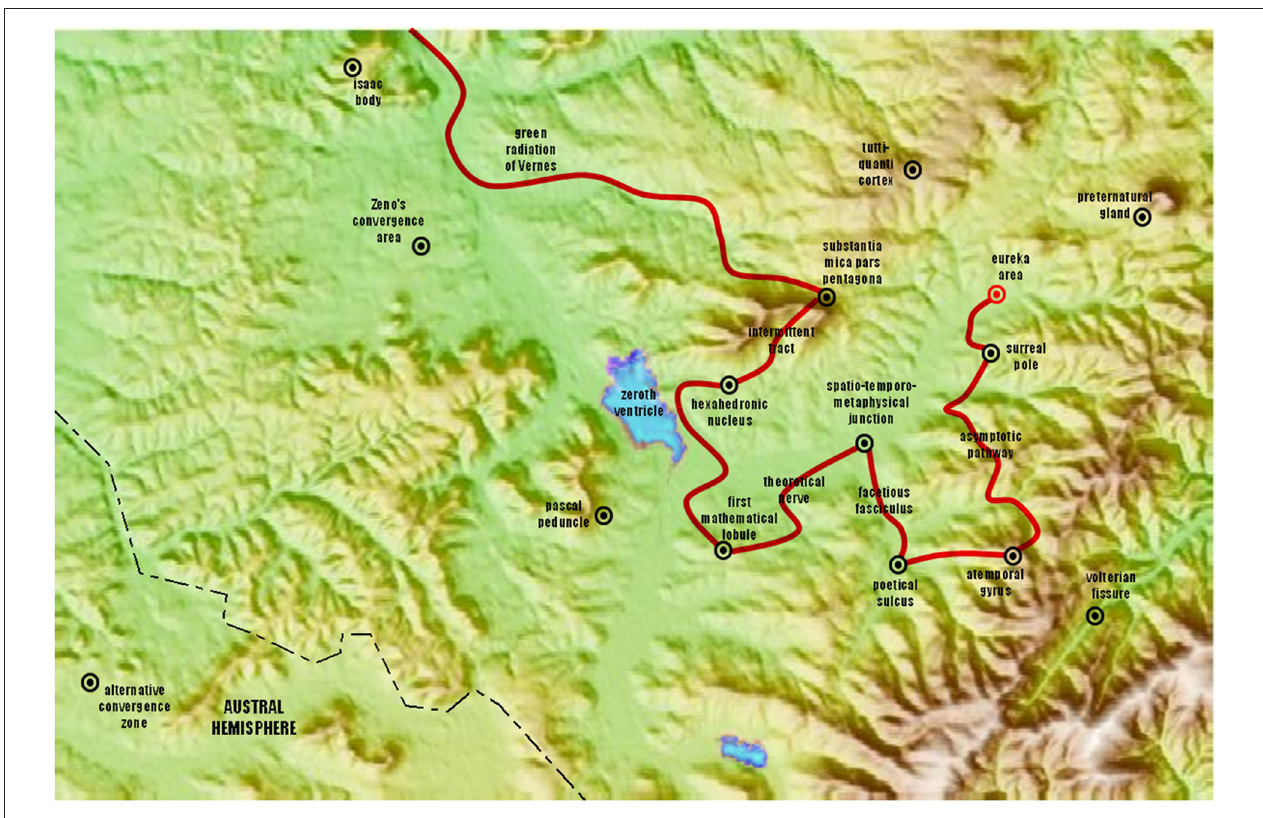
temporal neighborhoods, and it can reverse across spatial scales of observation (Tognoli and Kelso, 2013). The question is highly relevant though, when one is concerned with where and how to effect changes in the